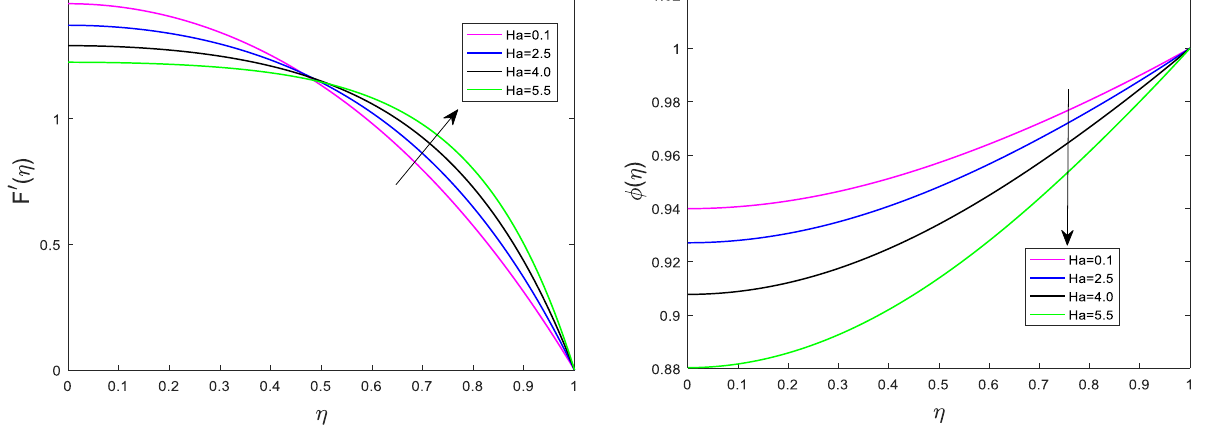
Figure 13: Effect of Ha on ϕ ( η ) for fixed S = 0.6, β = 5.0, N t = Kr = 0.1, Ω T = 0.5, Ω C = 1.5, Ec = 0.1, N b = 2.0, Pr = 0.7 and Sc =